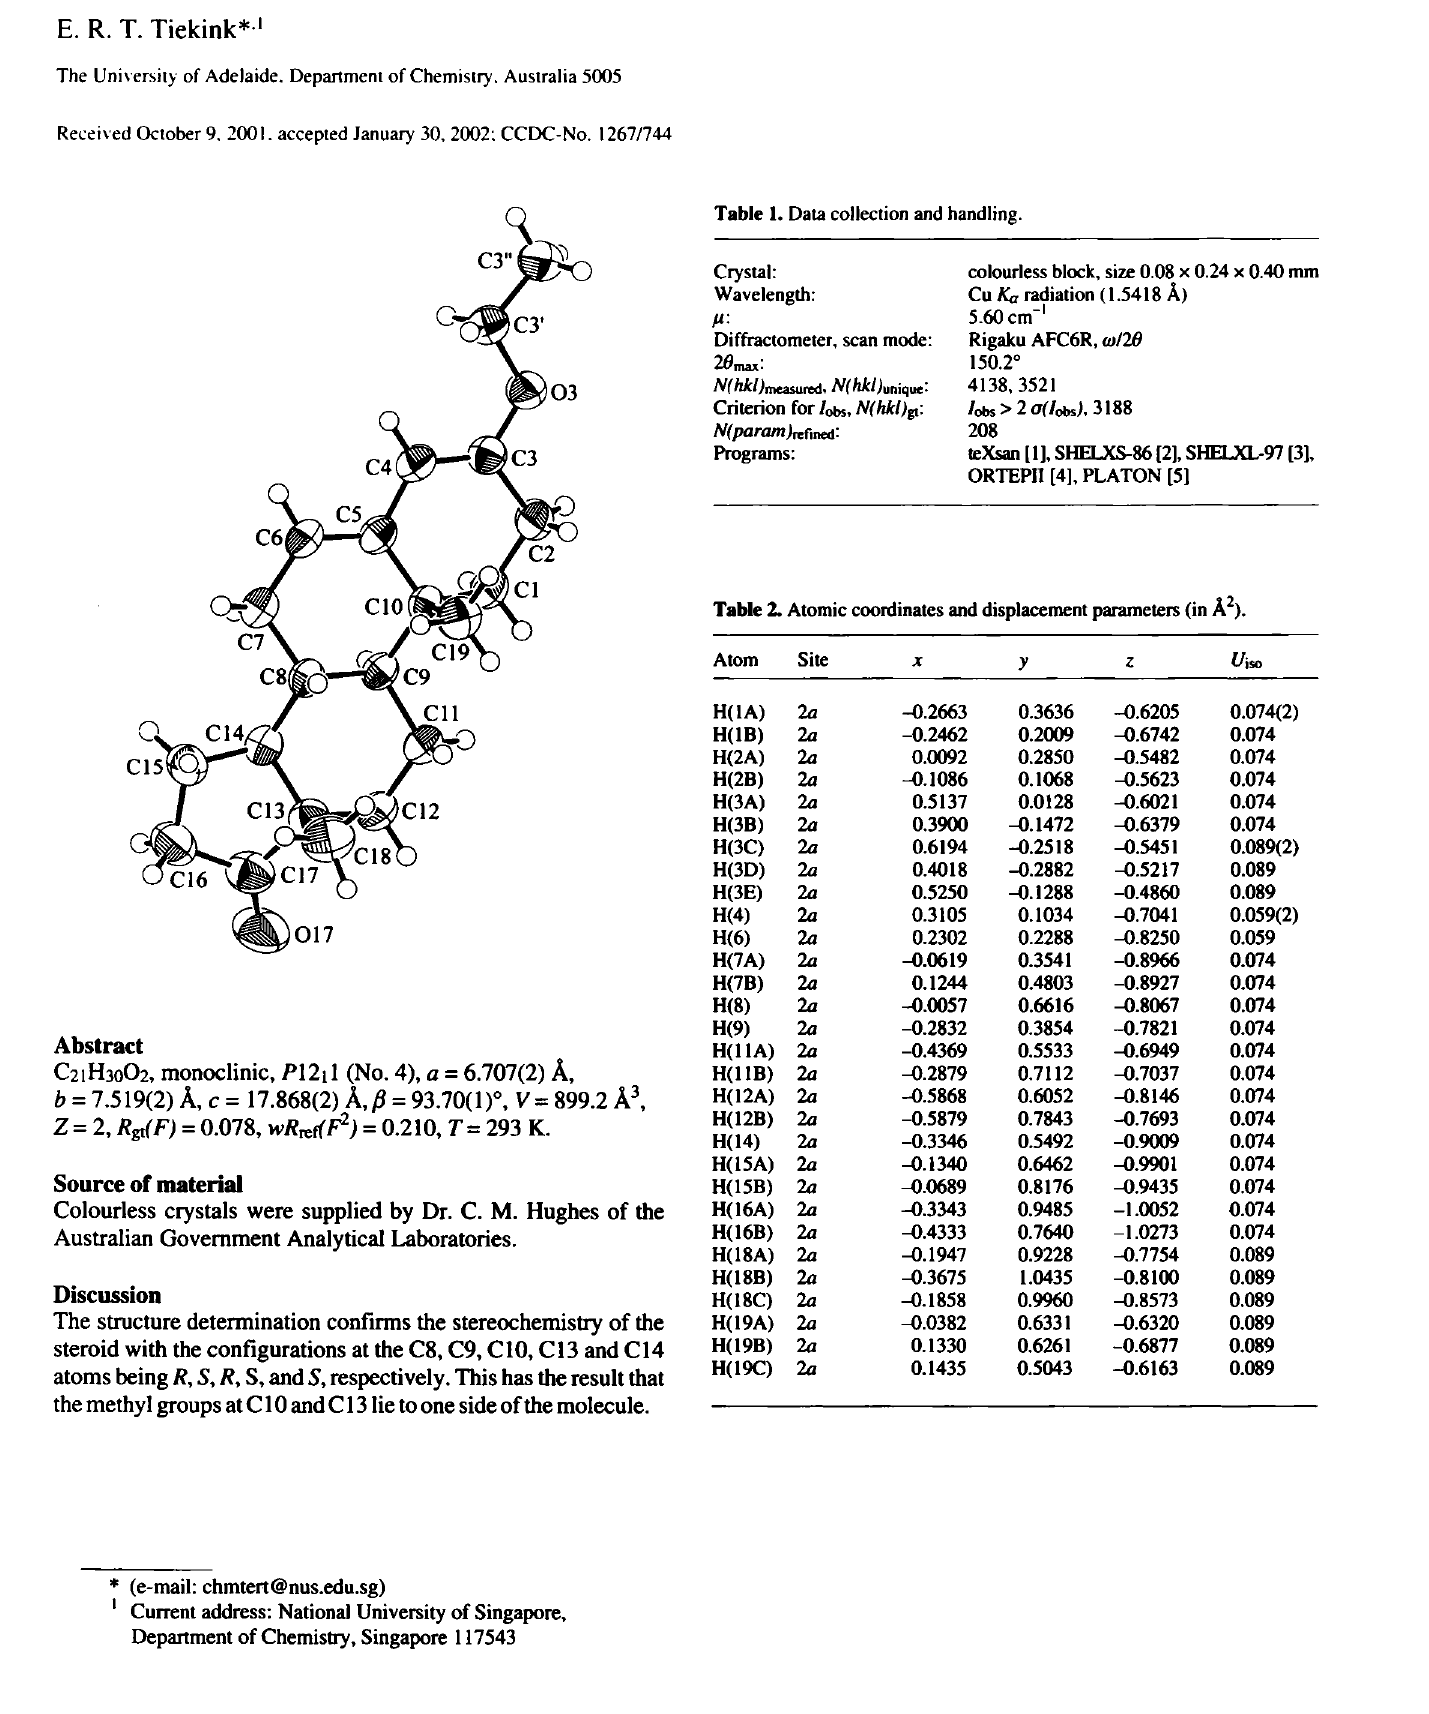
Table 1. Data collection and handling. Crystal: